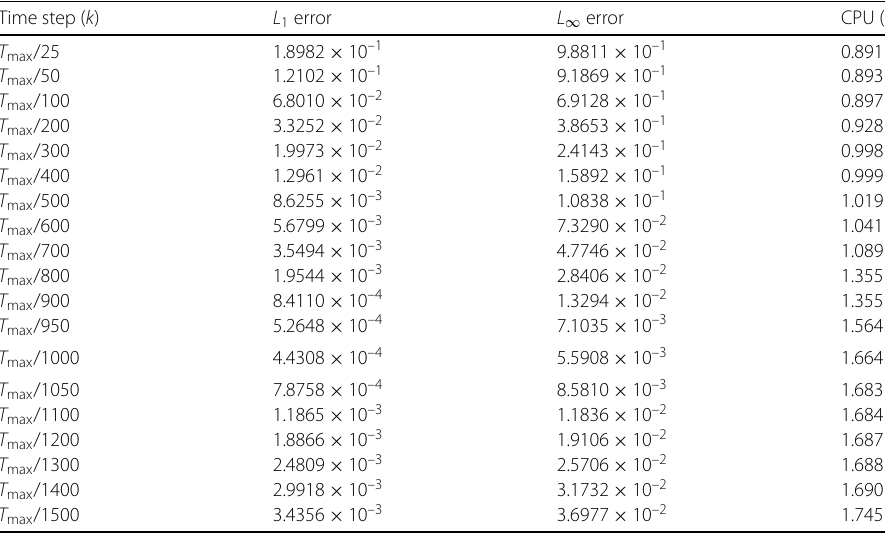
Table 11 L 1 and L ∞ errors and CPU time at some different values of time step size k for Problem 1